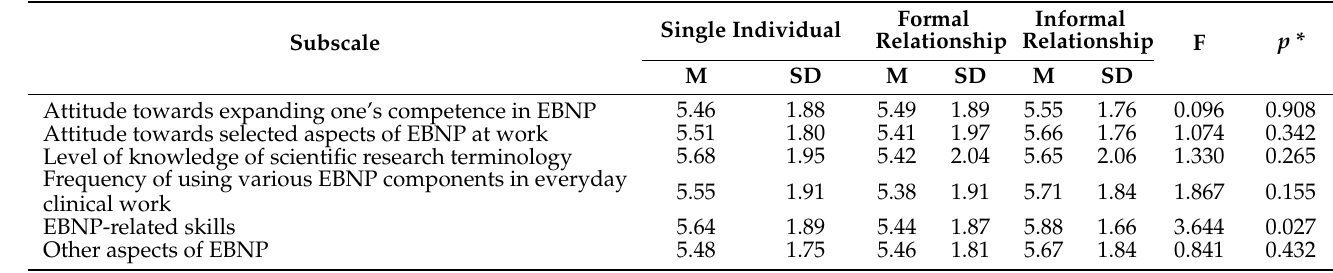
Formal Single Individual Relationship